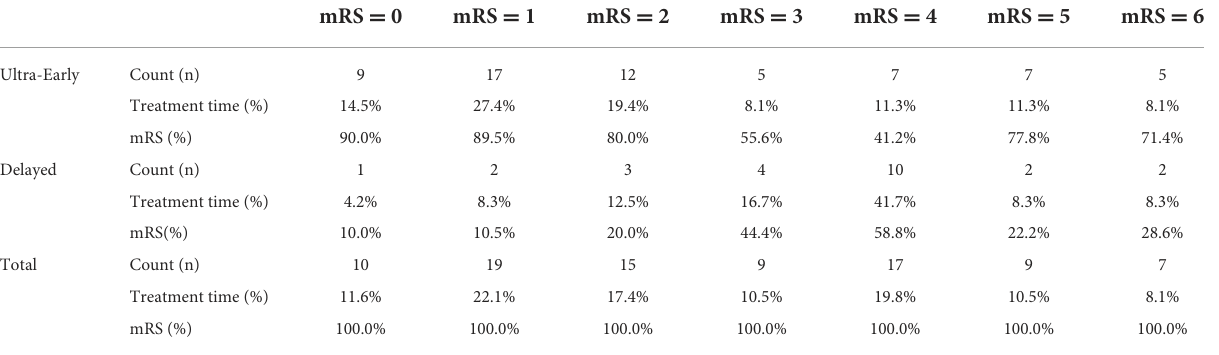
TABLE 1 mRS percentages for all